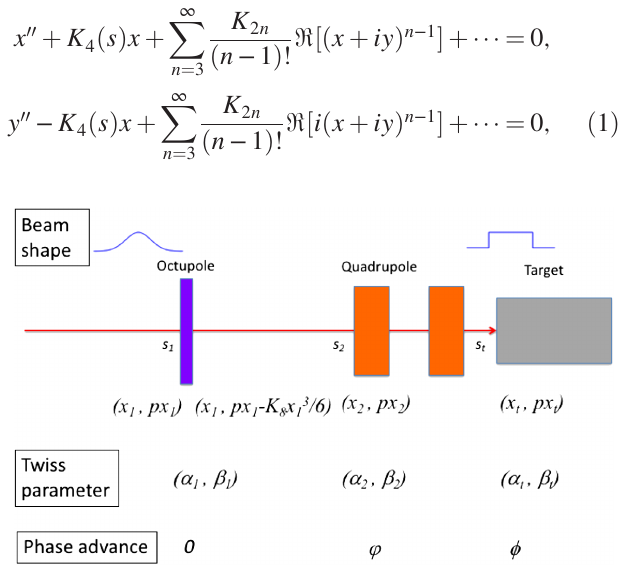
FIG. 1. Definition of beam transport parameters used in this